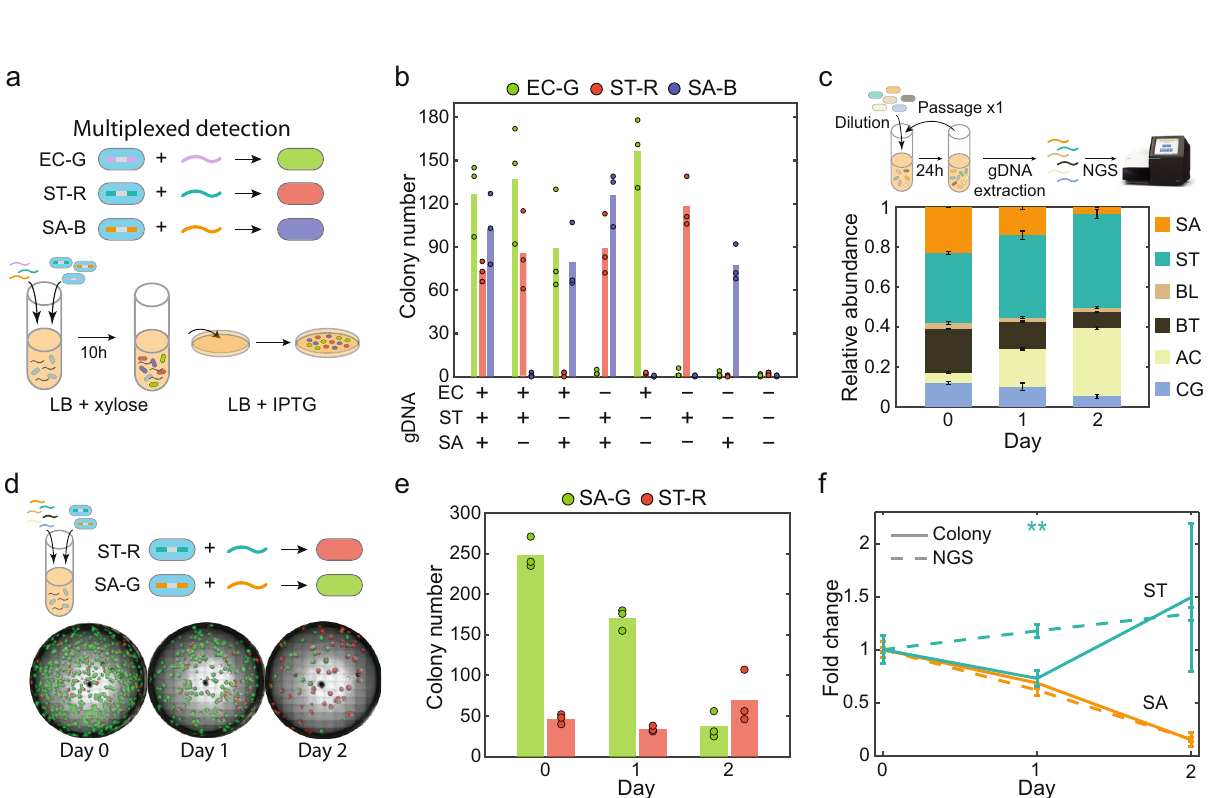
Fig. 3| Cell-basedDNA sensorscanperform multiplexeddetectionin complex samples. a Schematic of experimental procedure for multiplexed DNA detection. E. coli , S. typhimurium , and S. aureus DNA sensors were labeled with GFP (EC-G), RFP(ST-R)andBFP(SA-B),respectively.ThegDNAextractedfromthreestrainswas introduced into a mixed culture of sensors for transformation and selection. The appearance of colonies expressing GFP, RFP or BFP can indicate the presence of target DNA. b Bar plot of the numbers of GFP, RFP, or BFP positive colonies on selectiveagarplatesafteramixedcultureofEC-G,ST-R,andSA-Gwastransformed withcombinationsofdifferent species'gDNA(200ng/mLeach).Sensorsprecisely detectedthepresence/absenceoftargetspecies ’ gDNA.Barrepresentstheaverage of three technical replicates. c Relative abundance of six species in a synthetic microbial community composed of S. aureus (SA), S. typhimurium (ST), B.